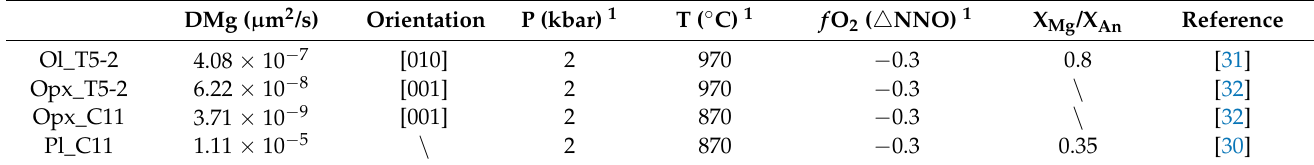
Table 1. Mg diffusion coefficients in olivine, orthopyroxene, and